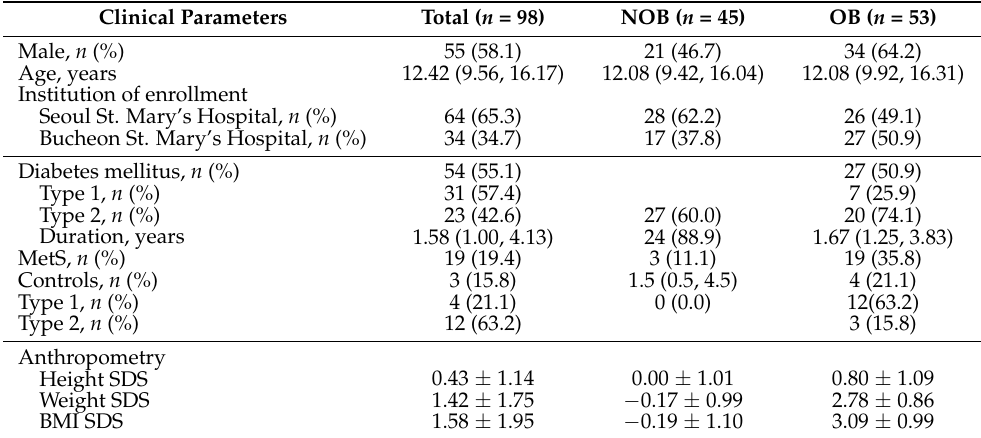
Table 1. Description of the study participants.